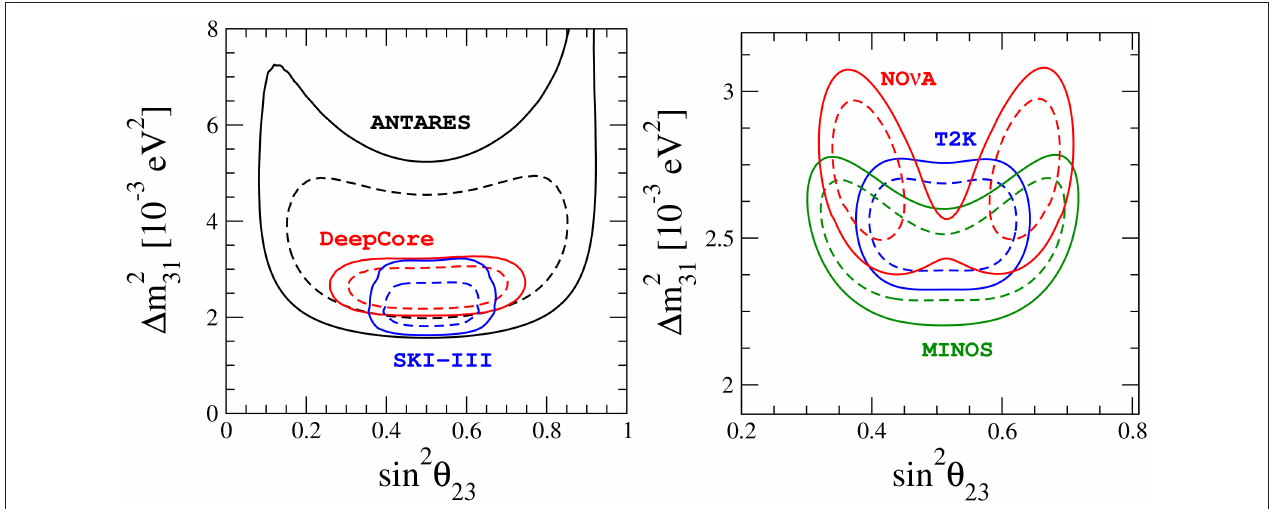
1 m 2 31 plane obtained from the atmospheric (Left) and long–baseline accelerator experiments (Right) , FIGURE 3 | 90 and 99% C.L. allowed regions at the sin 2 θ 23 − see the text for details. Notice the different scale in the 1 m 2 31 parameter. Both plots correspond to the normal ordered neutrino mass spectrum. Figures adapted de Salas et al.